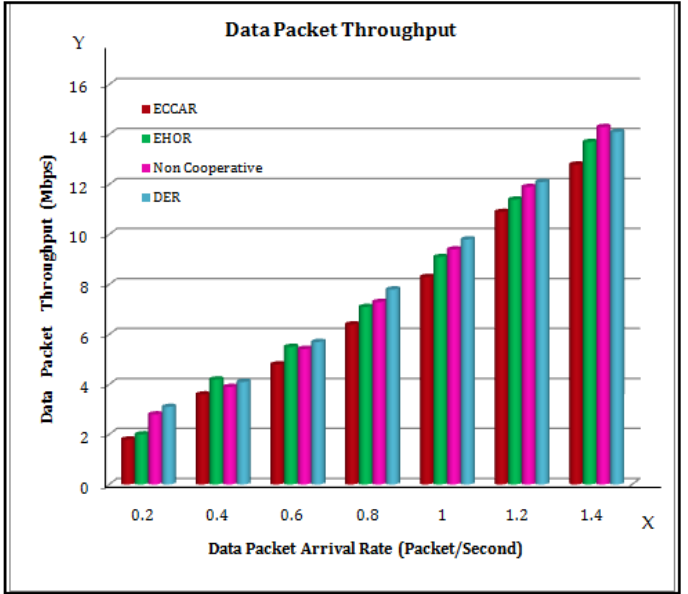
Figure 8. Data Packet Throughput.